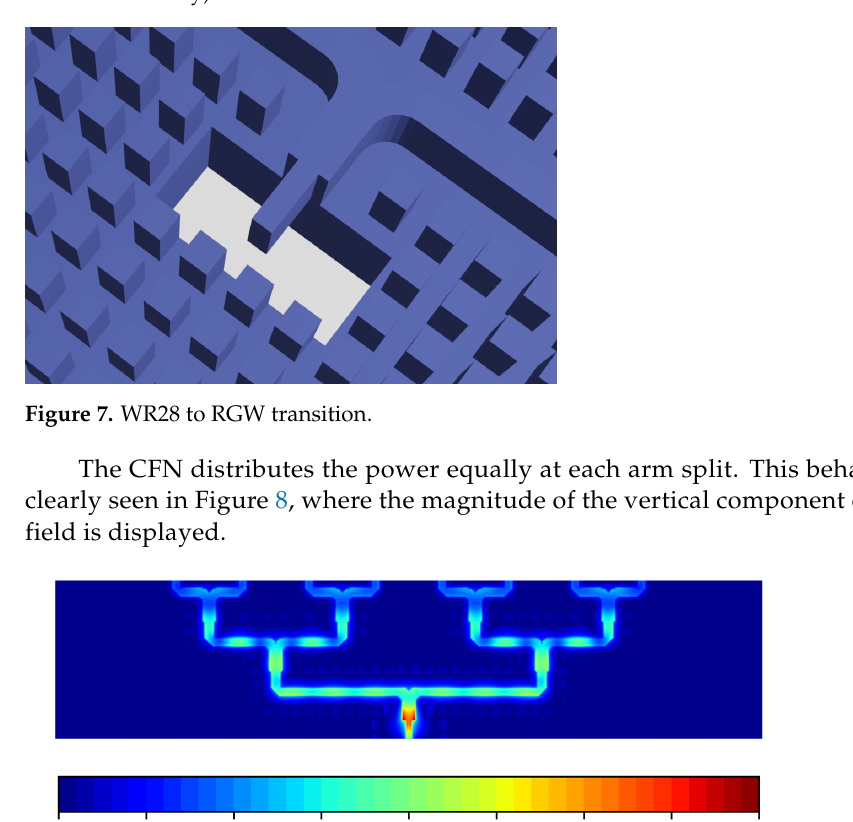
Figure 6. CFN implemented with air gap RGW (note the substrate used in the slow-wave RGW that feeds the TS array).